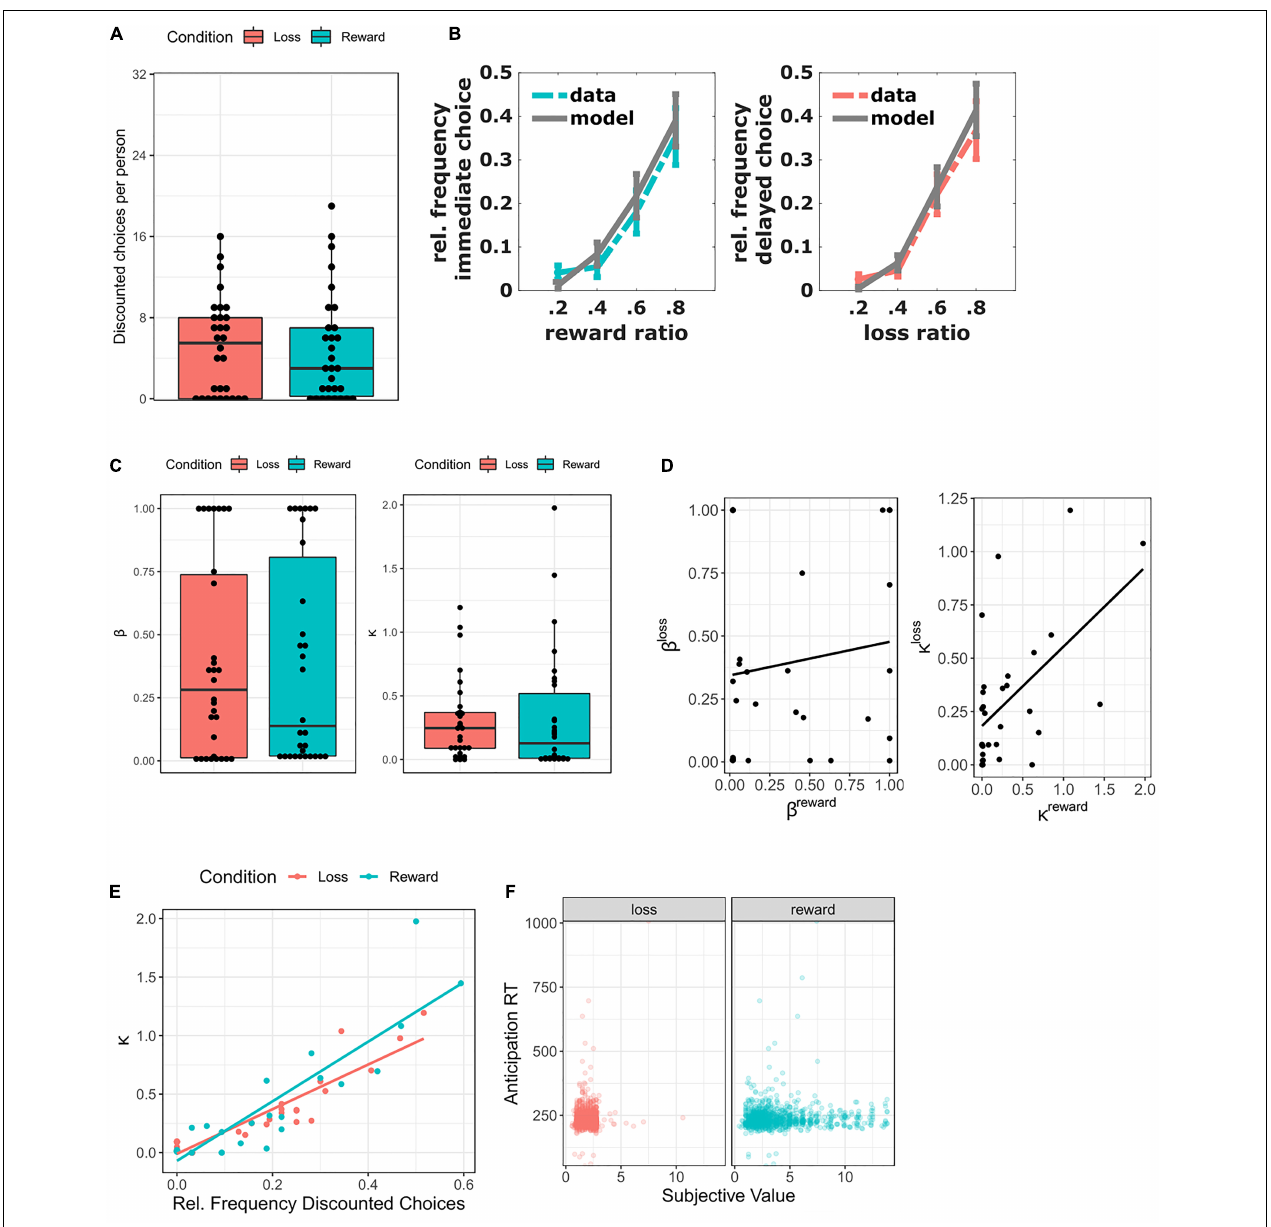
FIGURE 2 | Behavioral results ( N = 30). (A) Number of discounted choices per person (reward = immediate choices; loss = delayed choices). (B) Relative frequency of discounted choices per ratio between immediate and delayed options (means and standard errors of the mean). Gray: means and standard errors of the subject-wise hyperbolic model predictions. (C) : Distribution of κ and β values. (D) : Associations of κ and β between conditions. (E) : Association between κ parameters and relative frequency of discounted choices. (F) : Associations between reaction time during the anticipation phase and hyperbolic model-derived subjective values (note: absolute subjective values used for loss condition, “see Behavioral